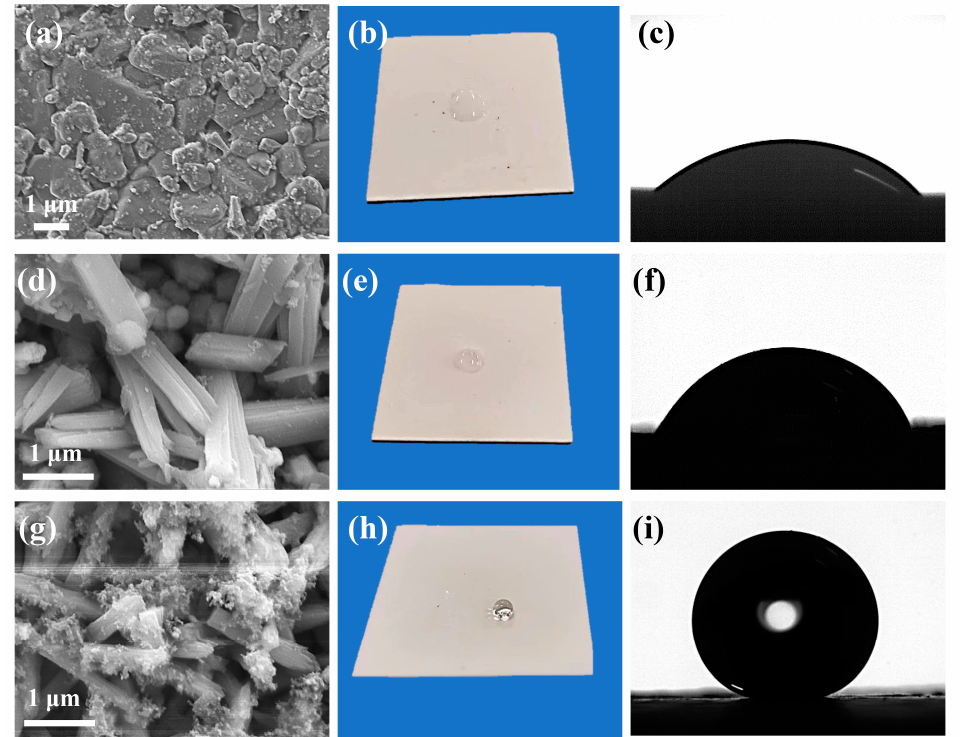
Figure 5. ( a – c ) SEM morphology and wettability of S1 sample surface (contact angle of 40 ± 3°); ( d – f ) SEM morphology and wettability of S2 sample surface (contact angle of 76 ± 2°); ( g – i ) SEM morphology and wettability of S3 sample surface (contact angle of 153 ± 3°).